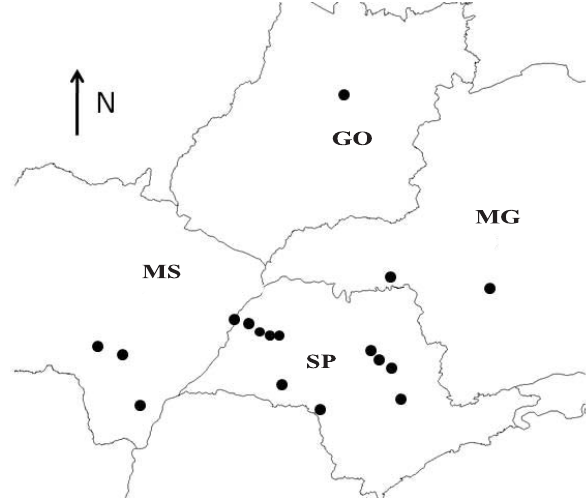
Figure 1. Regions where soil profile samples were